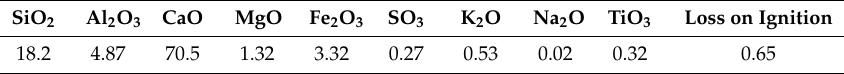
Table 2. Chemical composition of cement (%).